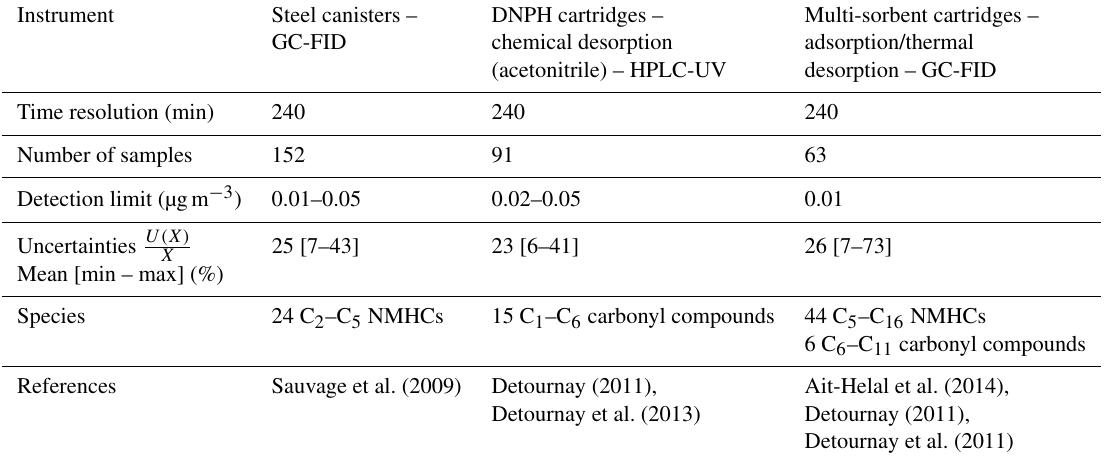
Table 1. Technical details of the set-up for VOC measurements during the field campaign from June 2012 to June 2014. Air samples were collected bi-weekly (every Monday and Thursday) at Ersa from 09:00 to 13:00UTC (from early November 2012 to late December 2012 and from early November 2013 to late June 2014) or from 12:00 to 16:00UTC (from early June 2012 to late October 2012 and from early January 2013 to late October 2013). VOCs are explicitly listed in Sect. S1 of the